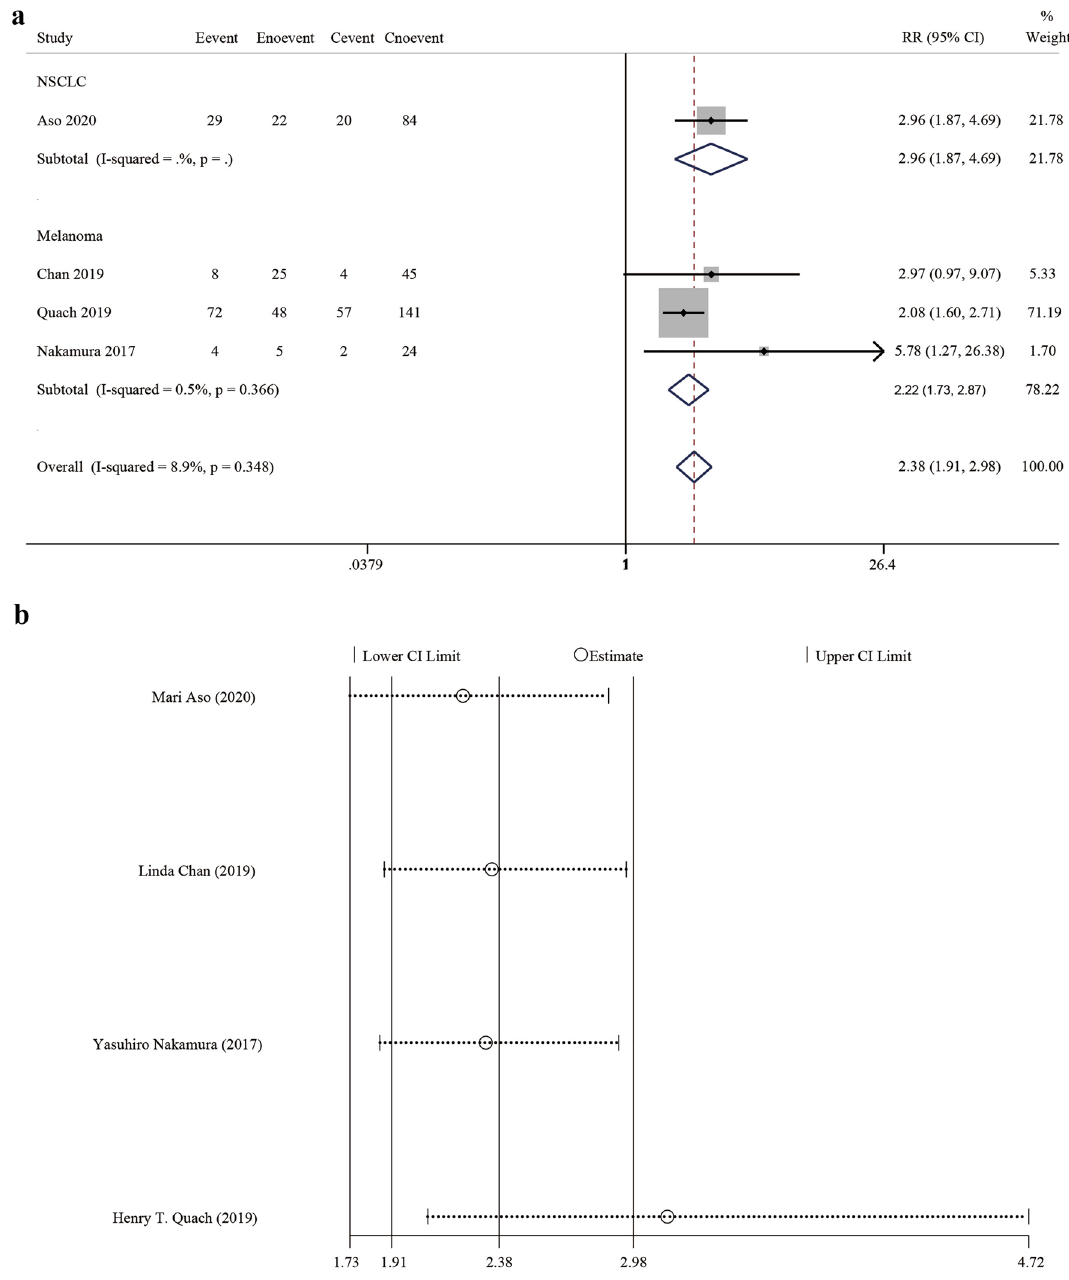
Figure 2. Forest plot showing the association between irCAE occurrence and ORR. ( a ) Subgroup analysis among cancer types and the ORR. ( b ) Sensitivity analysis of the ORR. The size of each square is proportional to the study’s weight. Horizontal lines indicate the 95% CIs. Diamonds indicate the pooled effect size with their corresponding 95% CIs. IrCAEs, immune-related cutaneous adverse events; ORR, objective response rate; CI, confidence interval; RR, relative